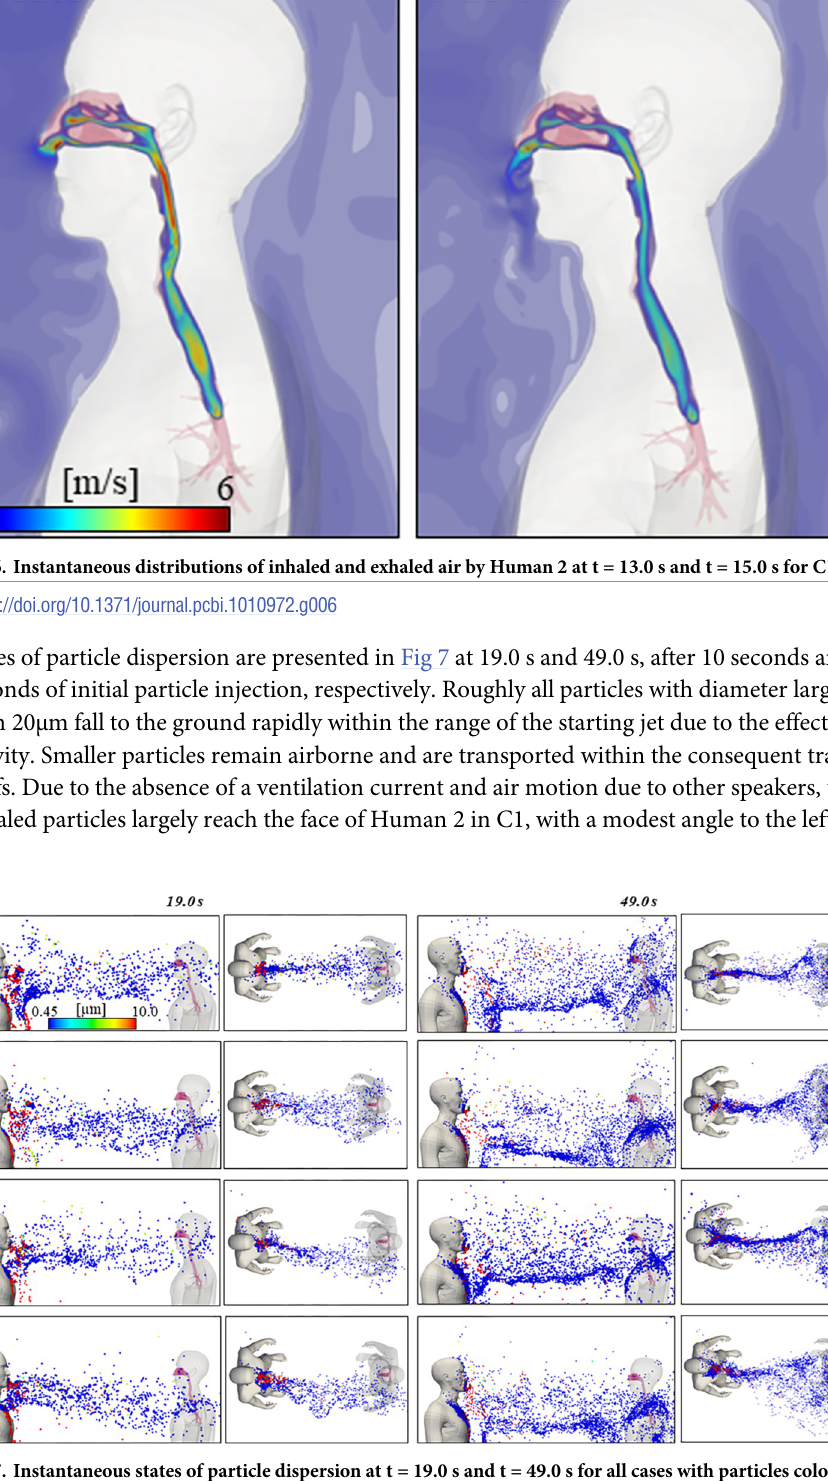
Fig 7. Instantaneous states of particle dispersion at t = 19.0 s and t = 49.0 s for all cases with particles colored according to their